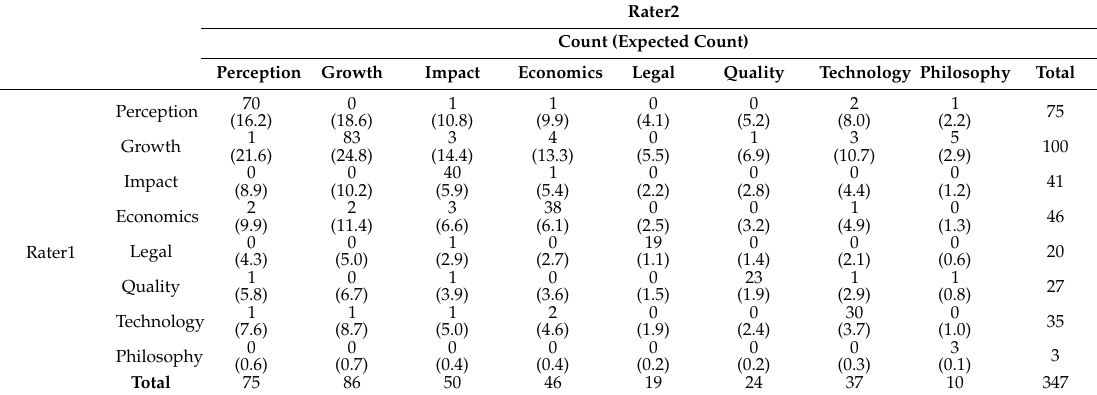
Table 2. Inter-rater agreement matrix.